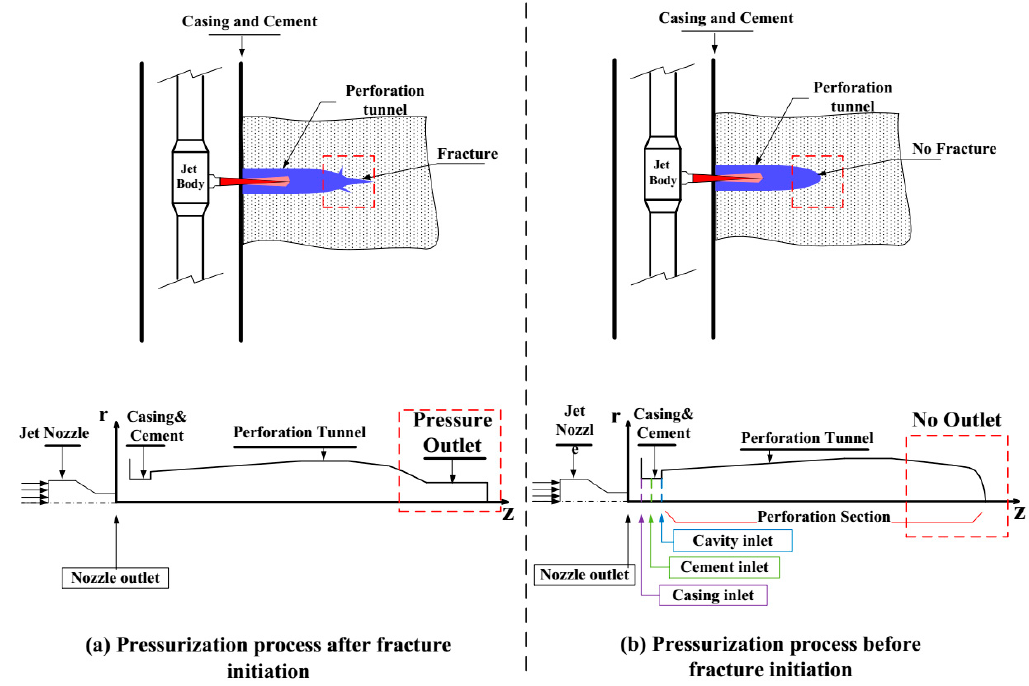
Figure 2. Schematic representation of two different simulation models.